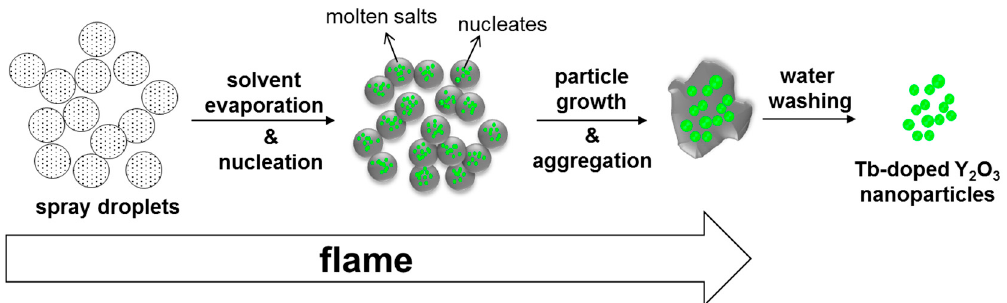
Figure 7. Schematic representation of Tb–doped Y 2 O 3 nanoparticle formation using salt-assisted FSP and subsequent water washing.